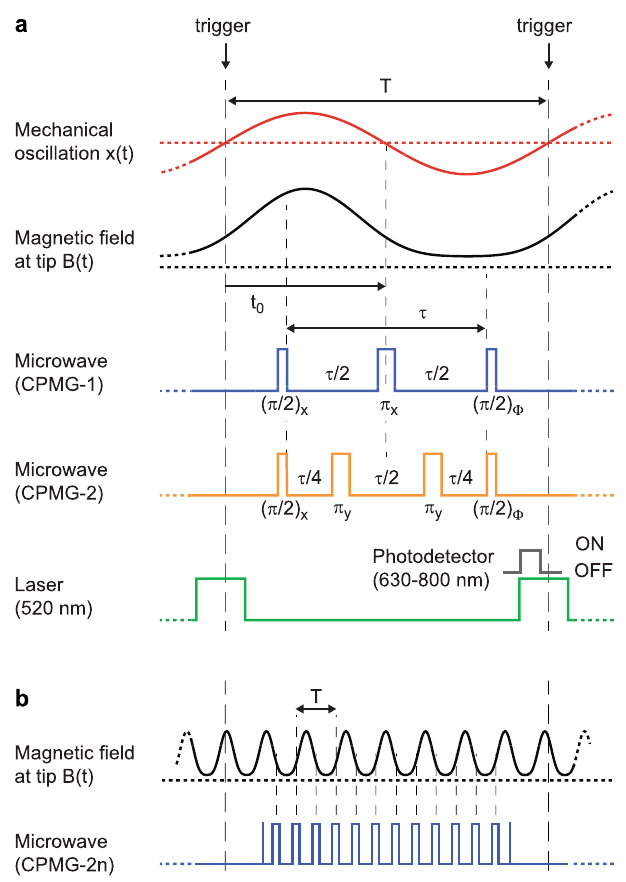
Fig. 2 AC quantum sensing protocol for gradient detection. a Timing diagram of sensor oscillation (red), resulting in magnetic fi eld at the sensor location (black), microwave pulse sequences for fi rst and second harmonic (blue and orange), laser pulses (green), and photodetector collection window (gray). Pulse indicators such as ( π ) x denote (angle) axis of the spin rotation. T = 1/ f TF is the oscillation period, τ < T is the sensor interaction time, and t 0 the trigger delay. We use a tuning fork with f TF ~ 32 kHz. Durations of pulses are ~2 μ s (laser) and ~100 ns (microwave π -rotation). b Scheme for detecting the fi rst harmonic signal over n oscillation periods in the regime τ ≫ T . Here, τ = nT and the number of π -pulses is 2 n